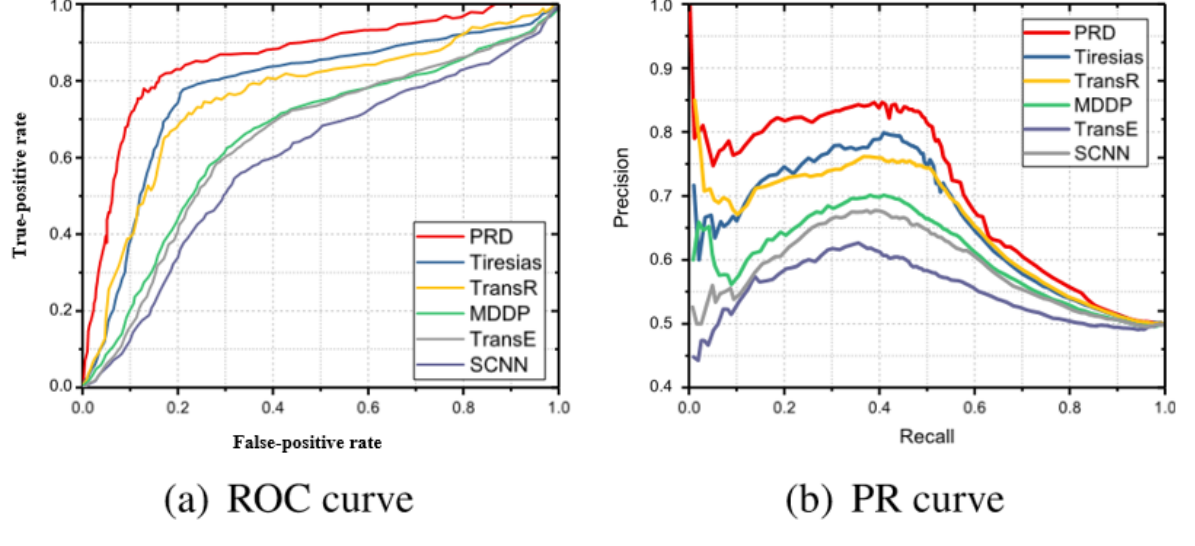
Figure 3. ROC and PR results of binary drug-drug interaction-type predictions. MDDP: multitask dyadic drug-drug interaction (DDI) prediction; ROC: receiver operator characteristic; PR: precision-recall.